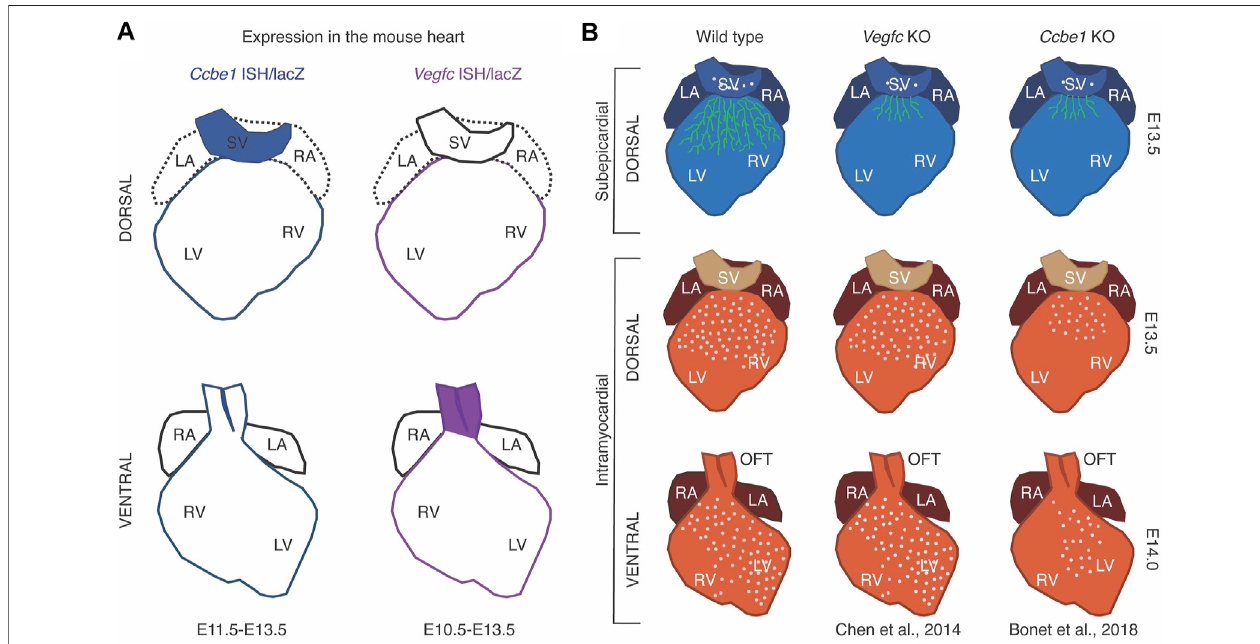
FIGURE 2 | Schematic of Ccbe1 and Vegfc expression and heart phenotypes. (A) : Ccbe1 and Vegfc expressions are colocalized in the epicardium from E10.5 onward. Ccbe1 expression is also present in the SV. Vegfc is expressed in the vessel wall of the aorta and pulmonary artery, whereas Ccbe1 is restricted to the aortic epicardium. (B) :Schematicrepresentationofheartphenotypein Ccbe1 KOvs Vegfc KOmiceshowsthatbothmutantlinesdisplayunderdevelopeddorsalsubepicardial coronary vessels, however, Ccbe1 phenotype extends to defective dorsal and ventral intramyocardial vessels. Green draws represent subepicardial vessels. Gray dots represent intramyocardial